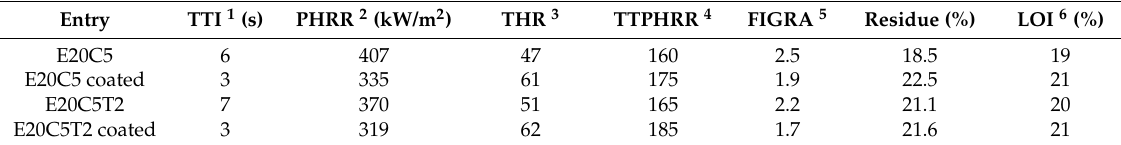
Table 2. FR data for epoxy-clay composites.